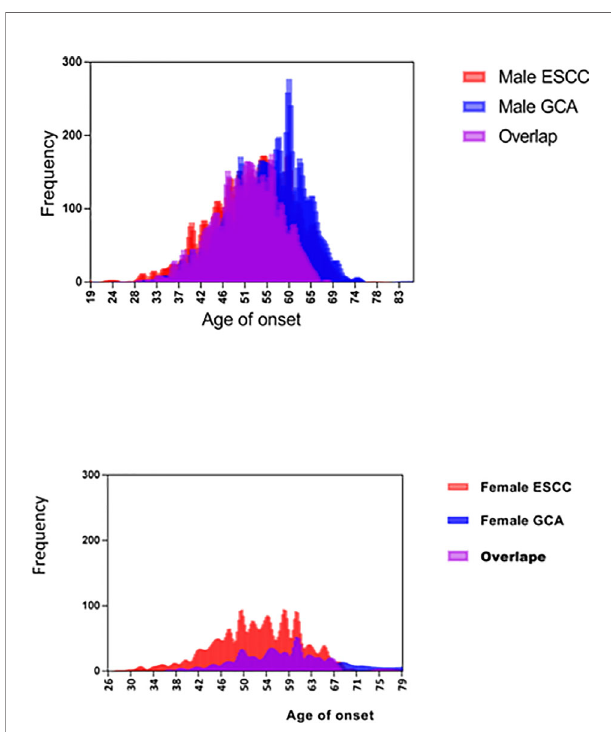
FIGURE 2 | Increased preponderance of male sex and older age at onset associated with patients with GCA in comparison with patients with